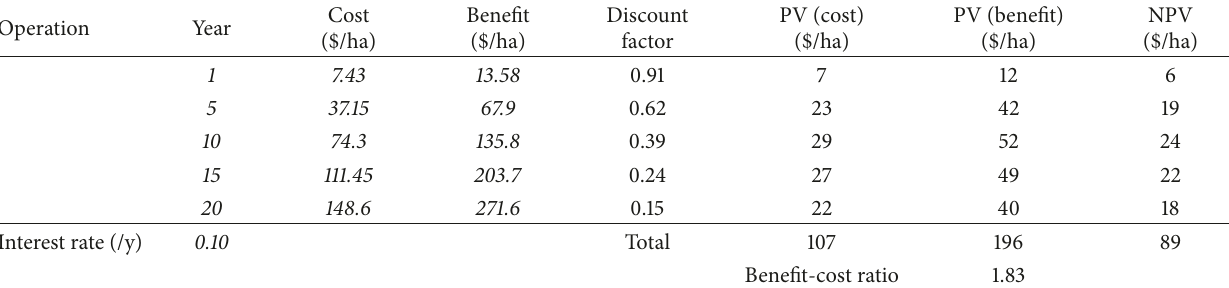
Table 8: Feasibility test based on estimated cost and benefits of improved carbon stock in